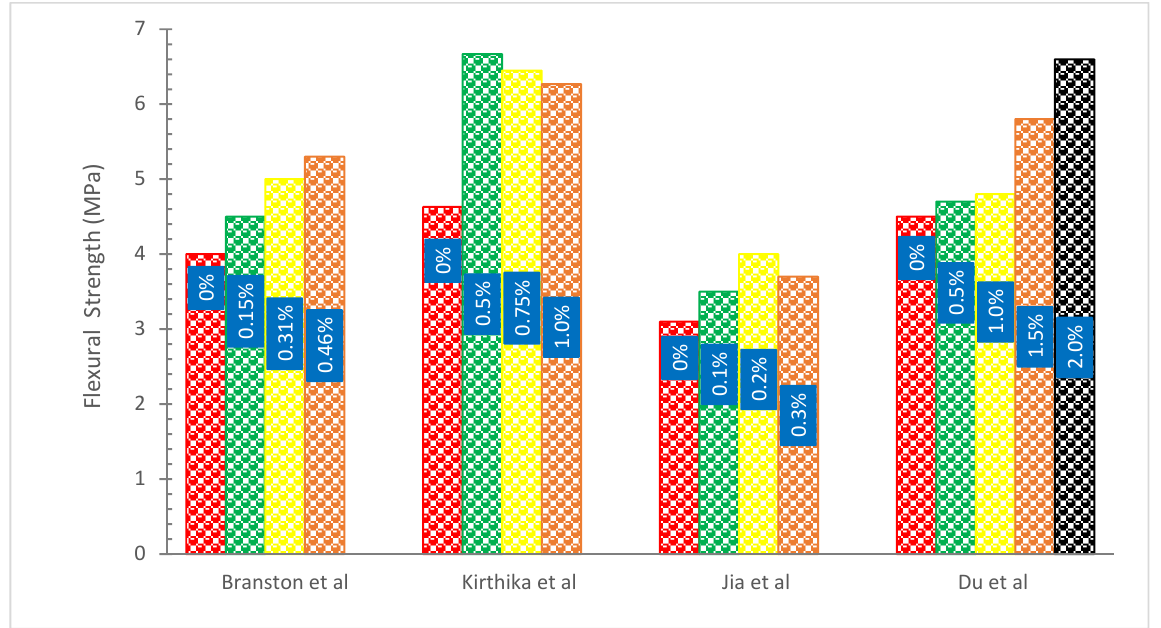
Figure 11. Flexural Strength: Data Source [33,67,68,70].